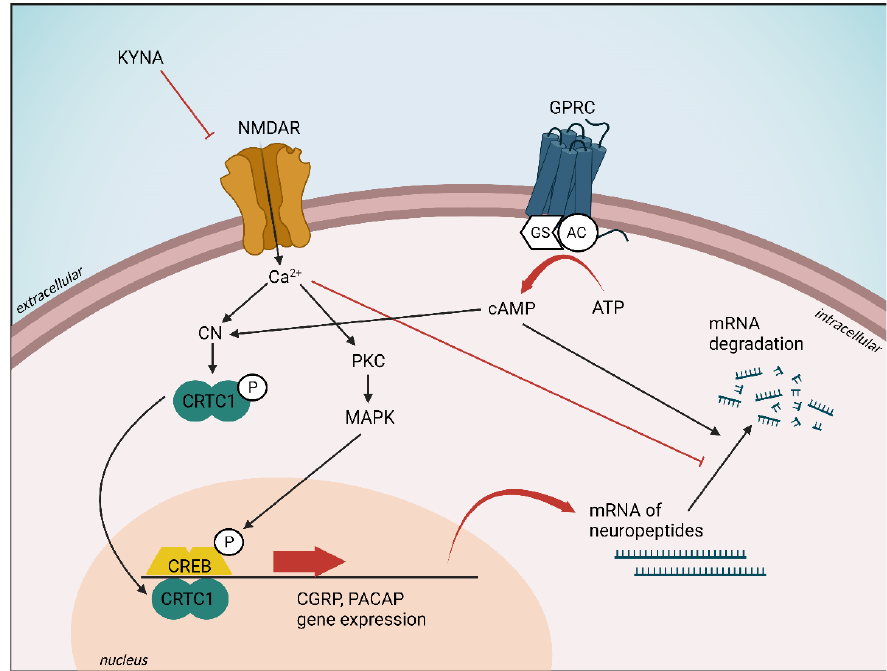
Figure 6. Proposed regulation of CGRP and PACAP gene expression. AC: adenylate cylase,